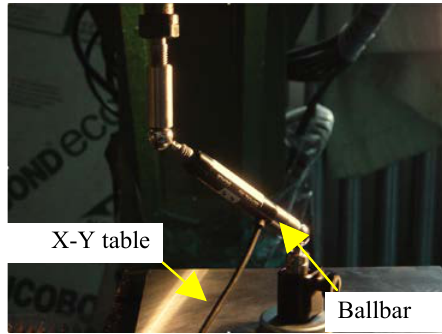
Fig. 3. X-Y table detection with ballbar.